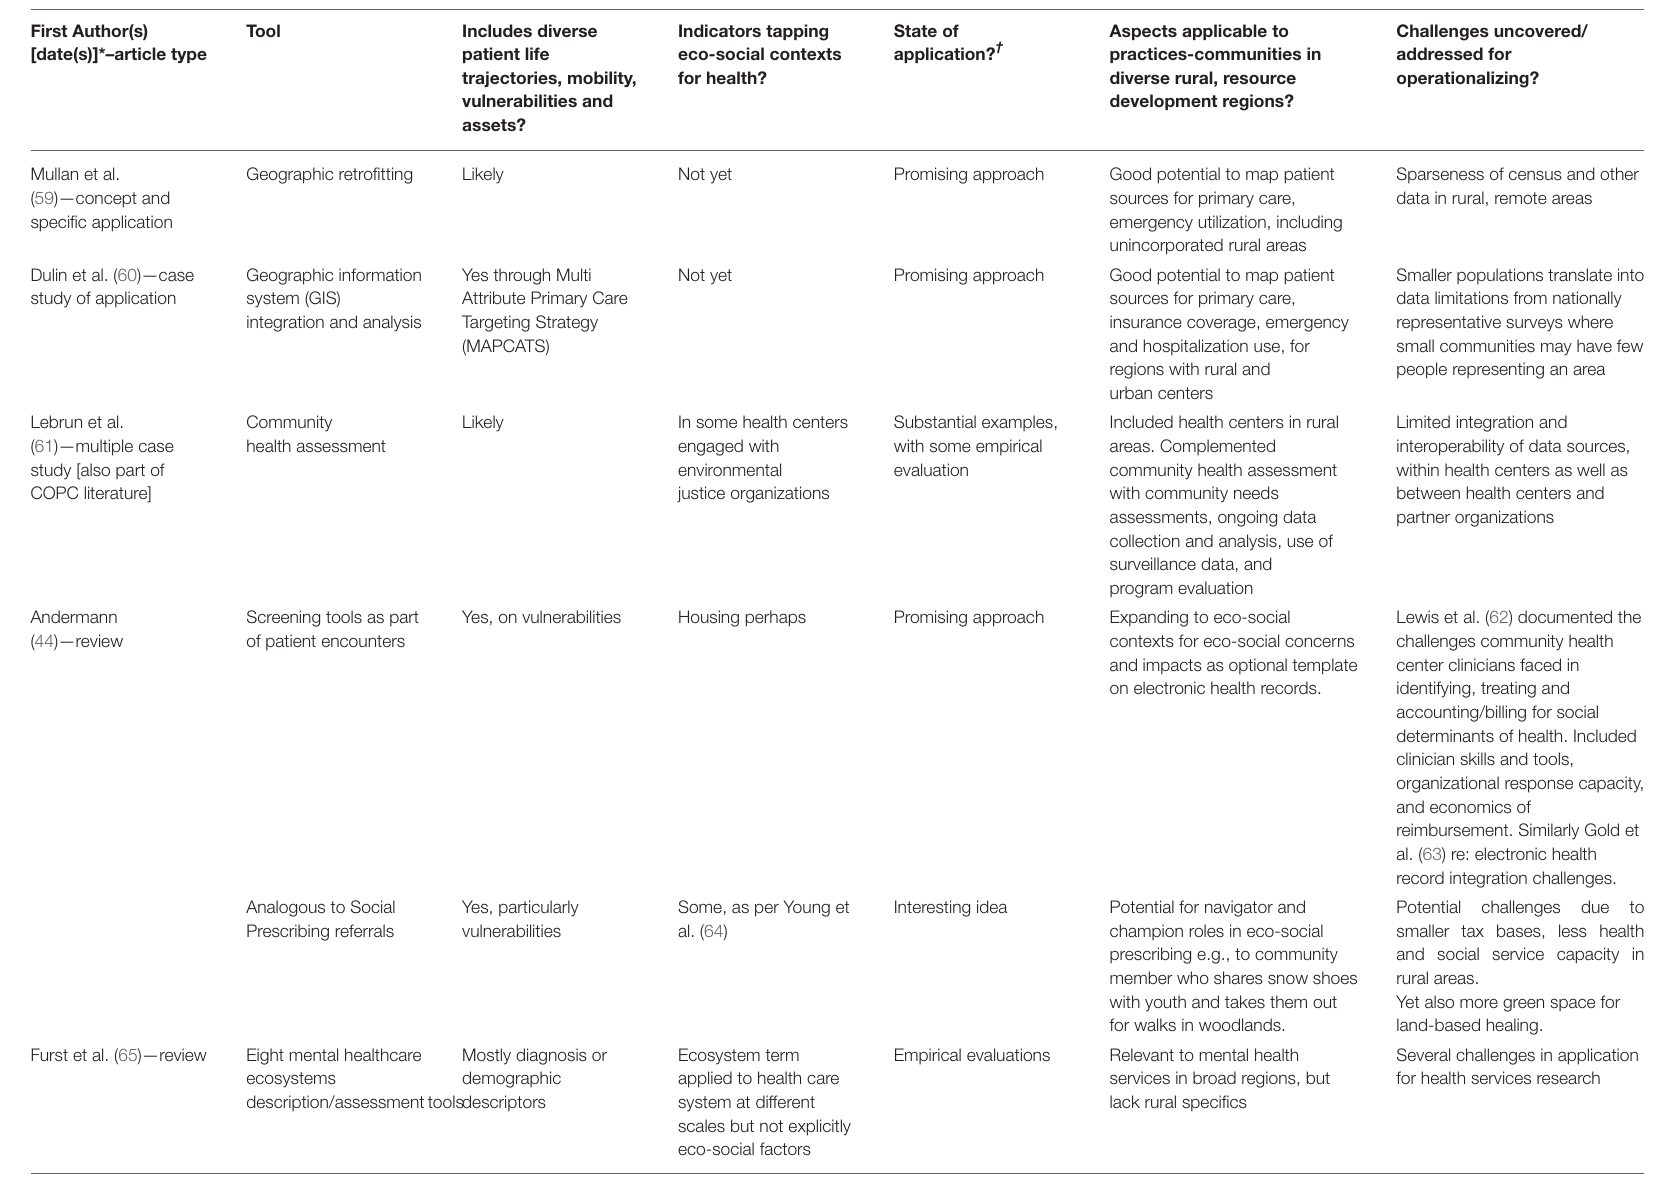
TABLE 3 | Assessment of potentially most relevant tools in relation to reflective